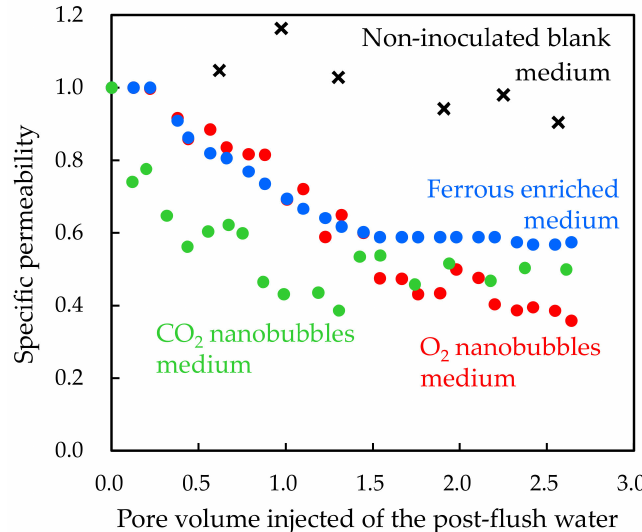
Figure 9. The temporal changes in specific permeability during the injection of the post-flush water after the in situ cultivation of P. aeruginosa .